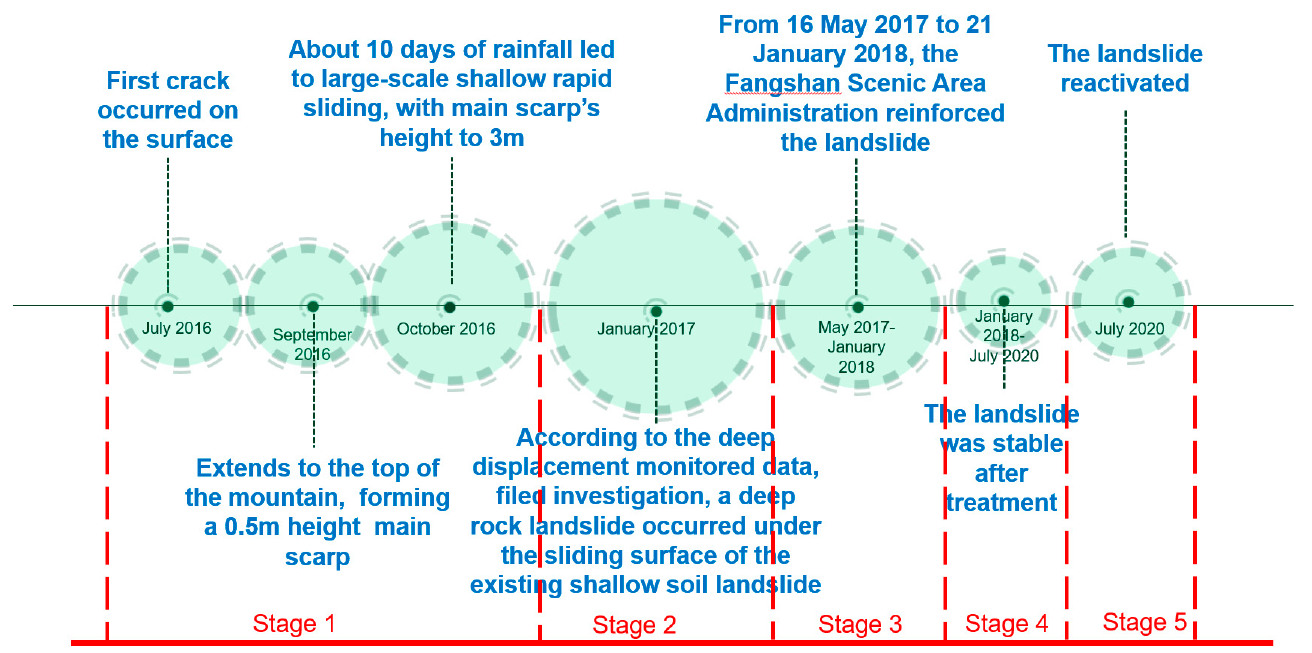
Figure 3. Timeline of the development of the Fangshan landslide.